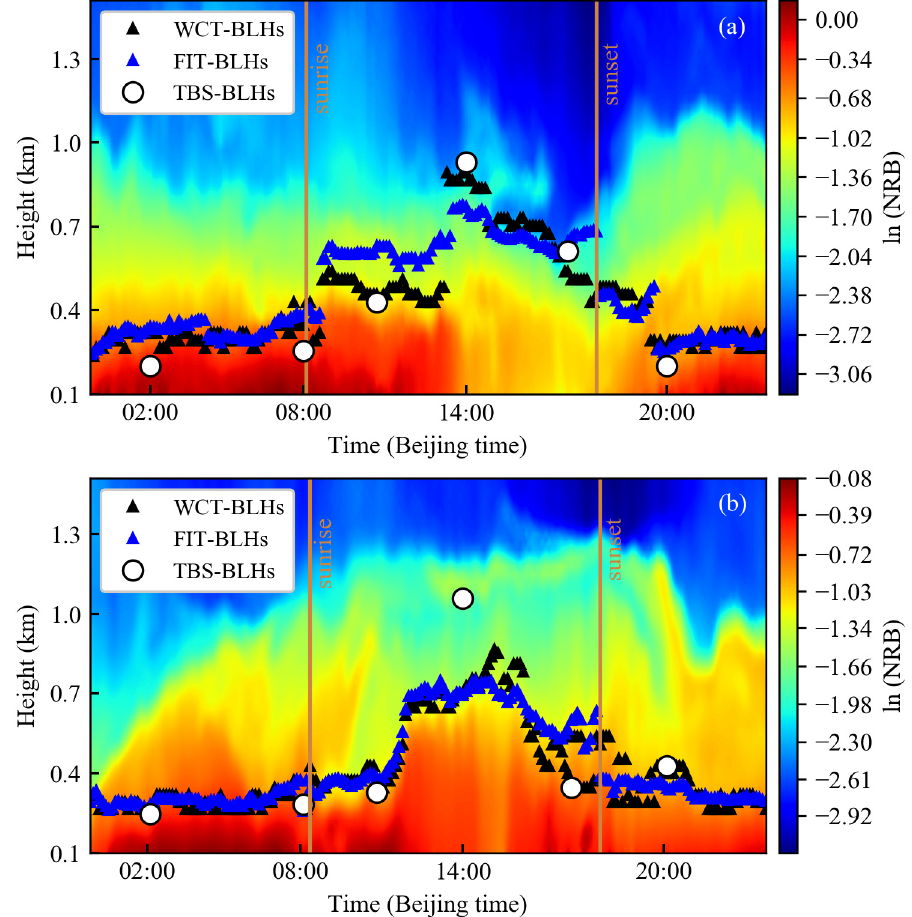
Figure 6. Evolution of atmospheric aerosols and BLHs from lidar observations on ( a ) 12 December and ( b ) 24 December 2019. The WCT-BLHs and FIT-BLHs were BLHs derived by WCT and FIT methods based on lidar data, respectively. TBS-BLHs were BLHs derived from tethered balloon soundings.